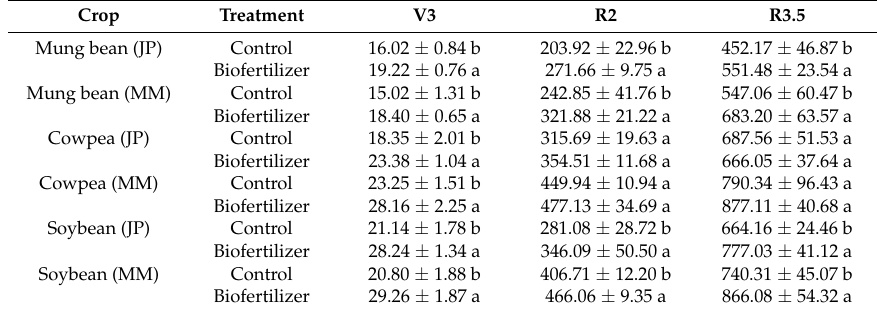
Table 7. Effect of biofertilizer on N uptake (mg pot − 1 ) of mung beans, cowpeas and soybeans at different growth